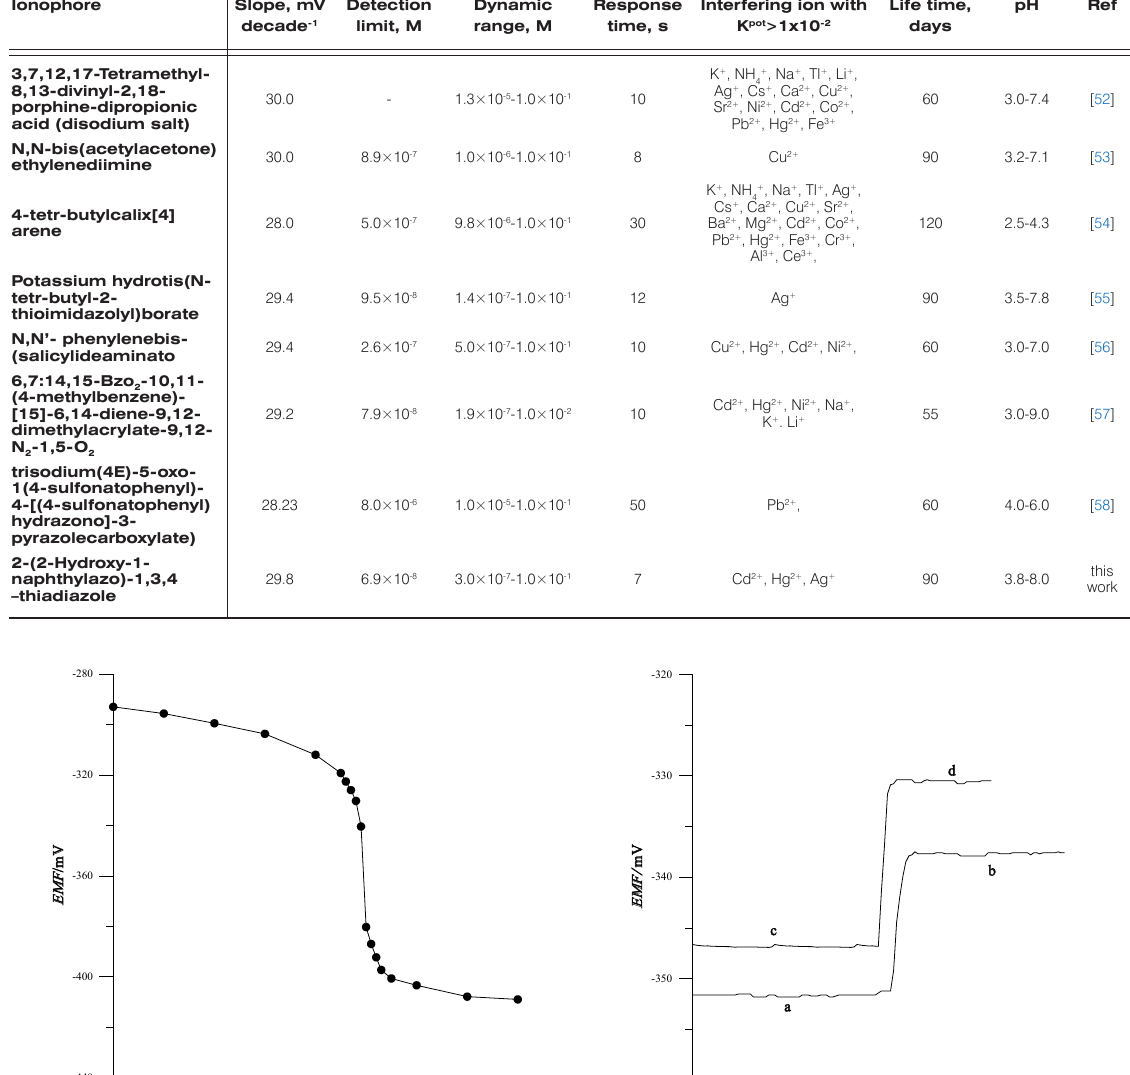
Table 4. Comparison of the properties of various Zn 2+ selective electrodes. Ionophore